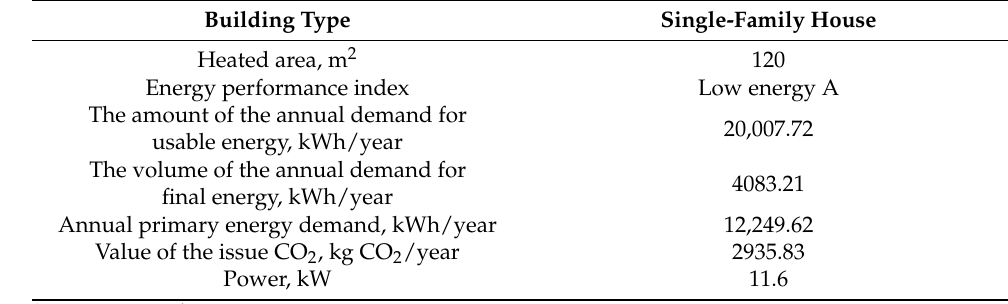
Table 10. Energy parameters of the building after using the air-to-water heat pump. Building Type